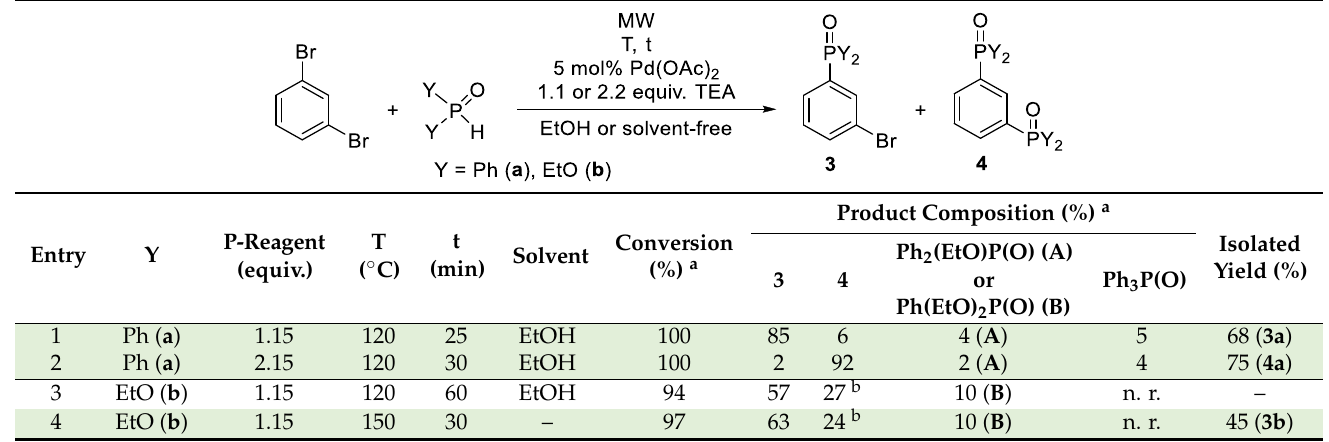
Table 5. P – C coupling reactions of